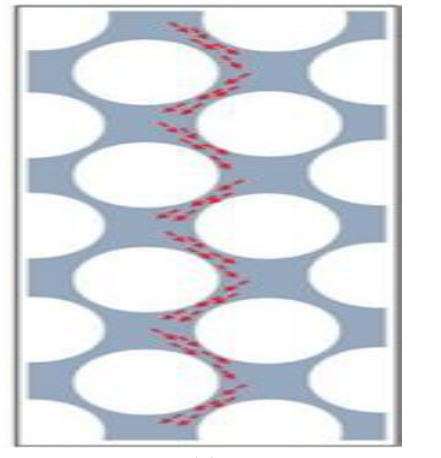
Figure 9. Corresponding HGM superimposed elements ( a ) Single; ( b ) Cubic; ( c ) Hexagonal HGM superimposed element. ( a-c ) Adapted with permission [54], Copyright 2018, MDPI.